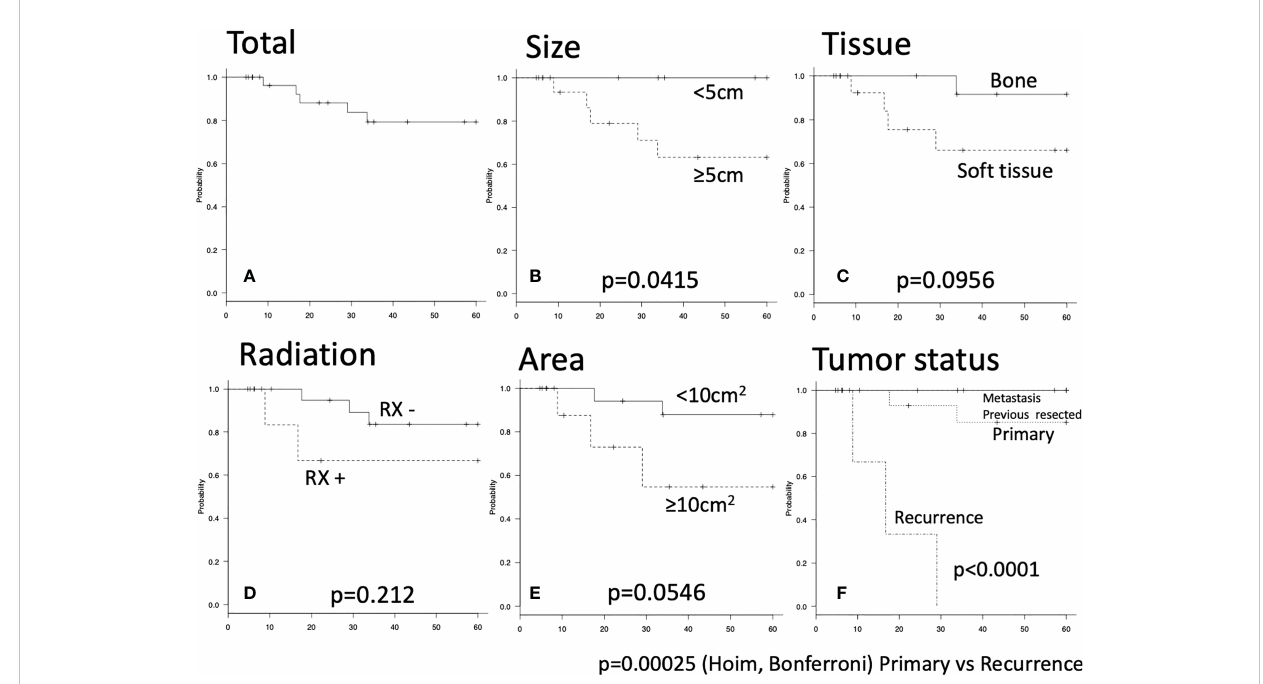
FIGURE 1 Five-year recurrence-free survival were shown by Kaplan-Meier carve. The log-rank p value of less than 0.05 was considered as statistically signi fi cant. (A) Total fi ve-year recurrence-free survival. (B – E) There were no signi fi cant differences. (F) Signi fi cant difference was seen between primary and recurrence group by Holm and Bonferroni test